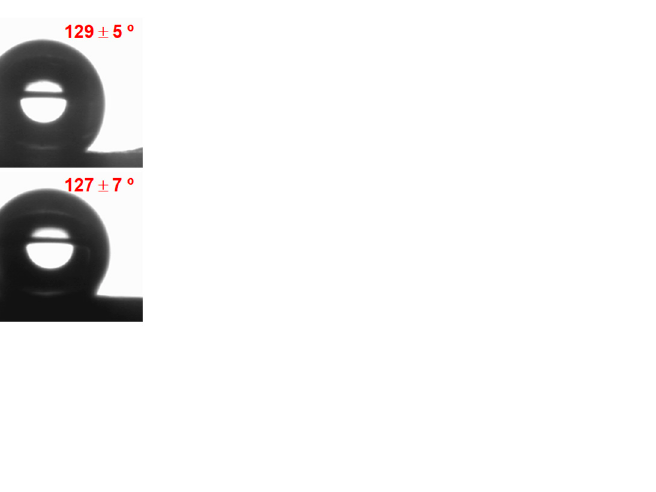
Figure 4. Images of water droplets over the surface of the prepared materials together with the average values of the contact angles obtained: ( a ) 0.0%; ( b ) 0.4%; (c) 1.0%; ( d ) 2.0%; ( e ) 3.0% of MWCNT.